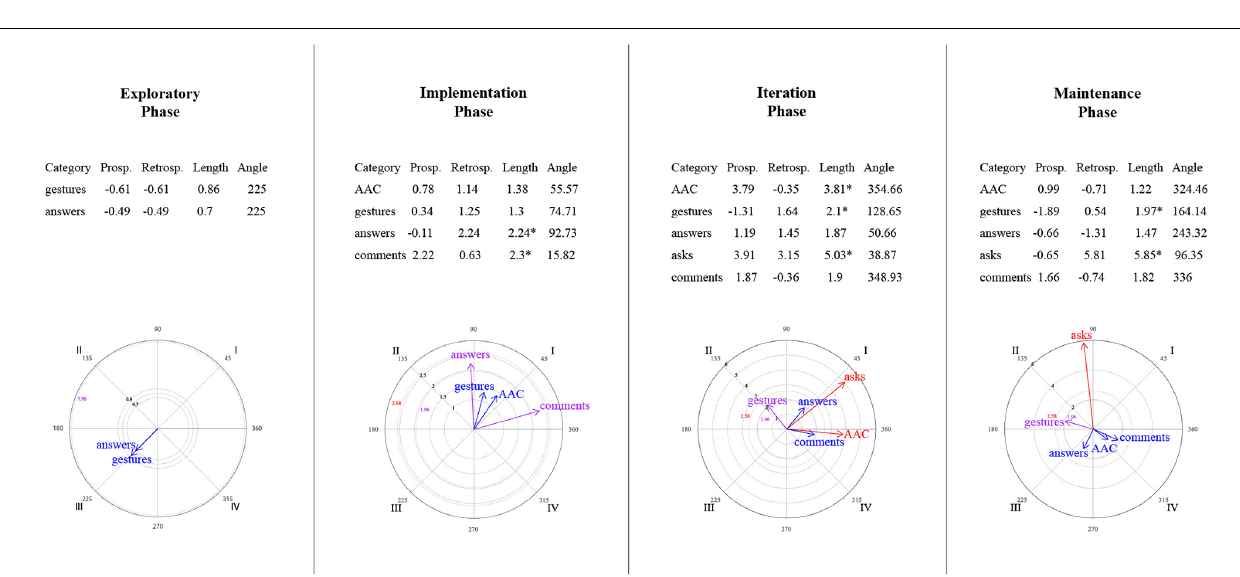
FIGURE 10 | Vectors corresponding to the mother’s emotion-related open-ended question as focal behavior, and the child’s emotion-related communicative turns [answers, comments, asks] and methods of expression [AAC, conventional gestures] as conditional behaviors.